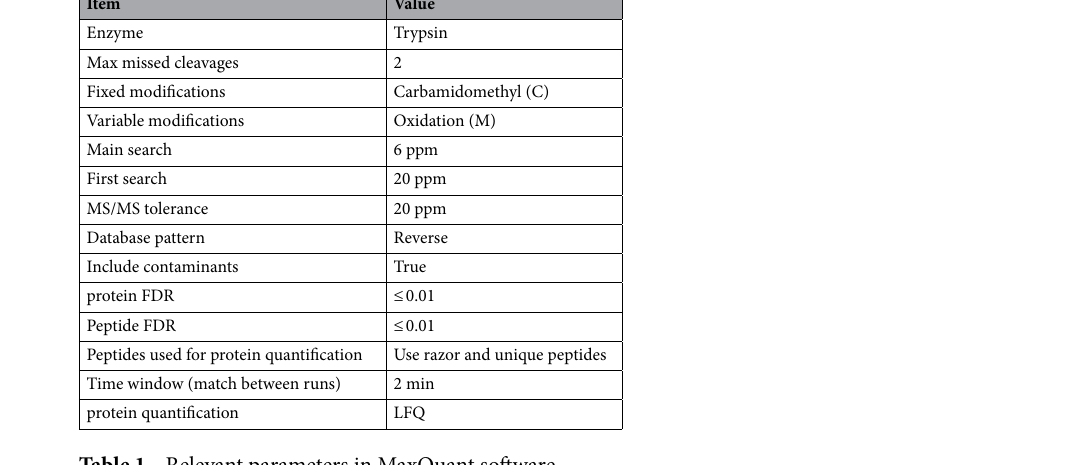
Table 1. Relevant parameters in MaxQuant